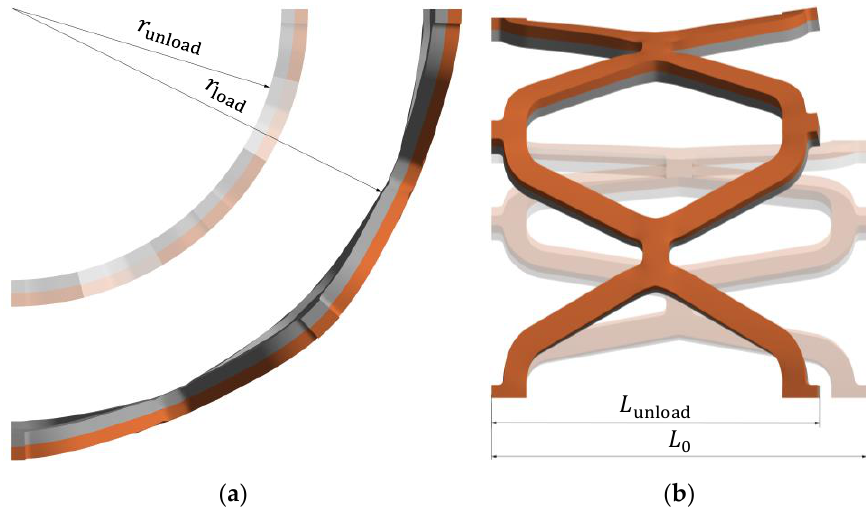
Figure 5. Spring-back effect: ( a ) radial elastic recoil; ( b ) foreshortening.